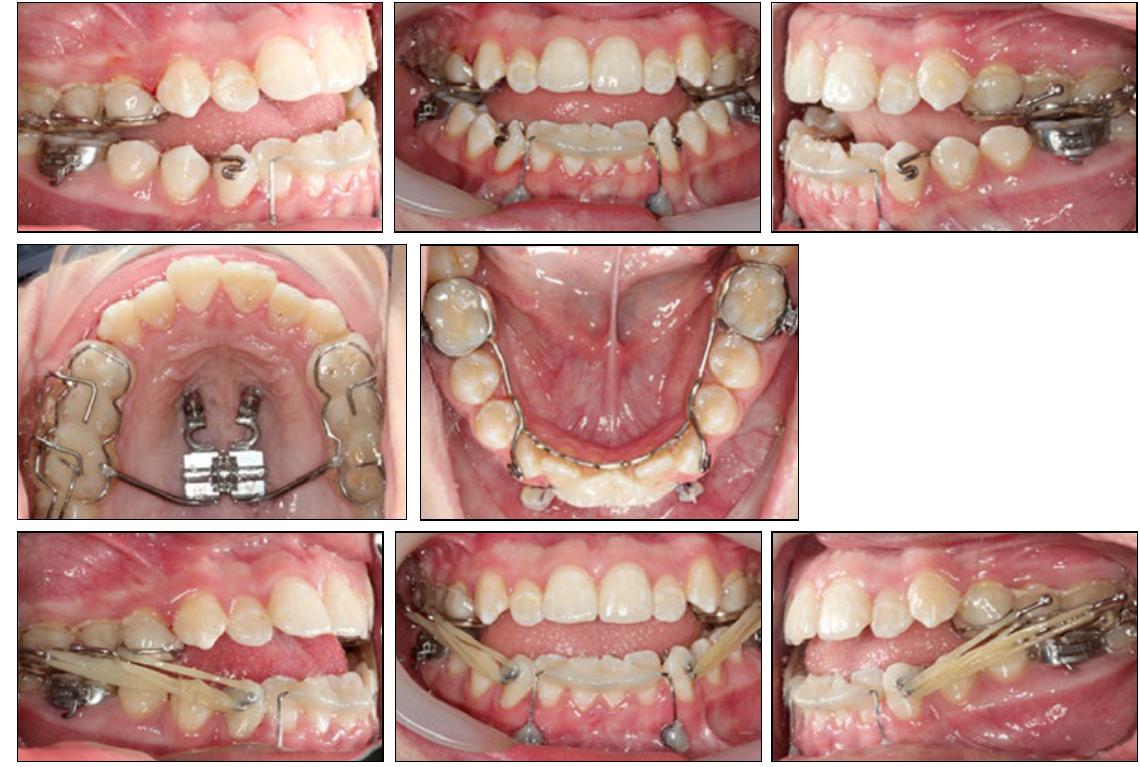
Figure 1. Appliance design. Intraoral photos with the appliances in